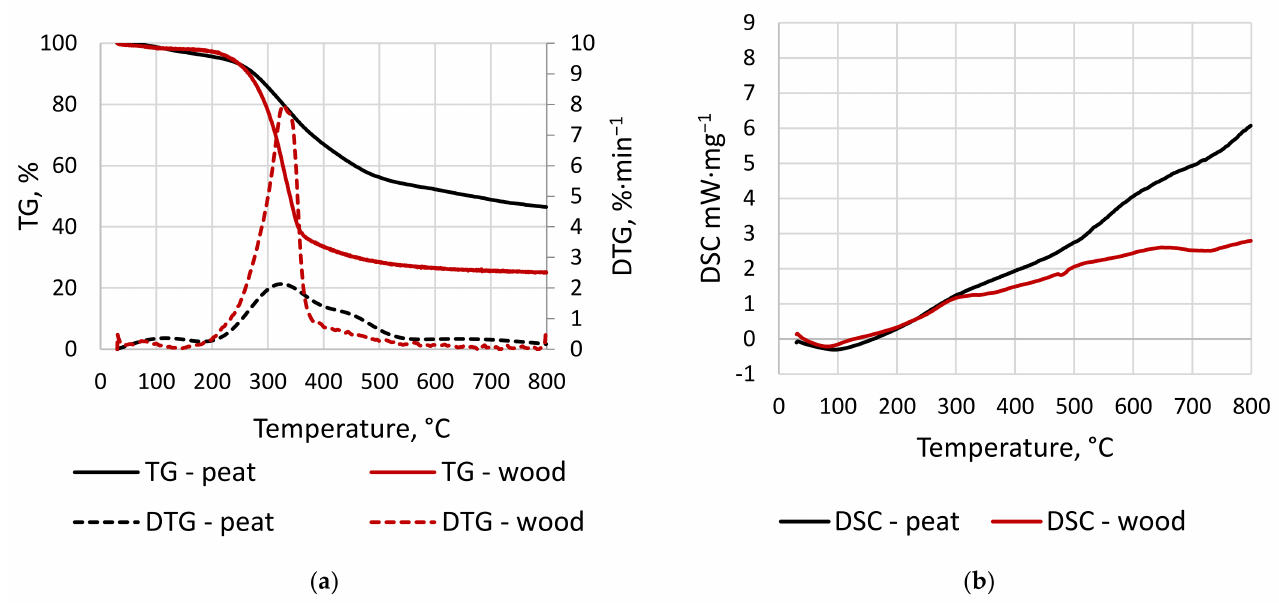
Figure 2. Thermal analysis results of ( a ) TG/DTG, ( b )